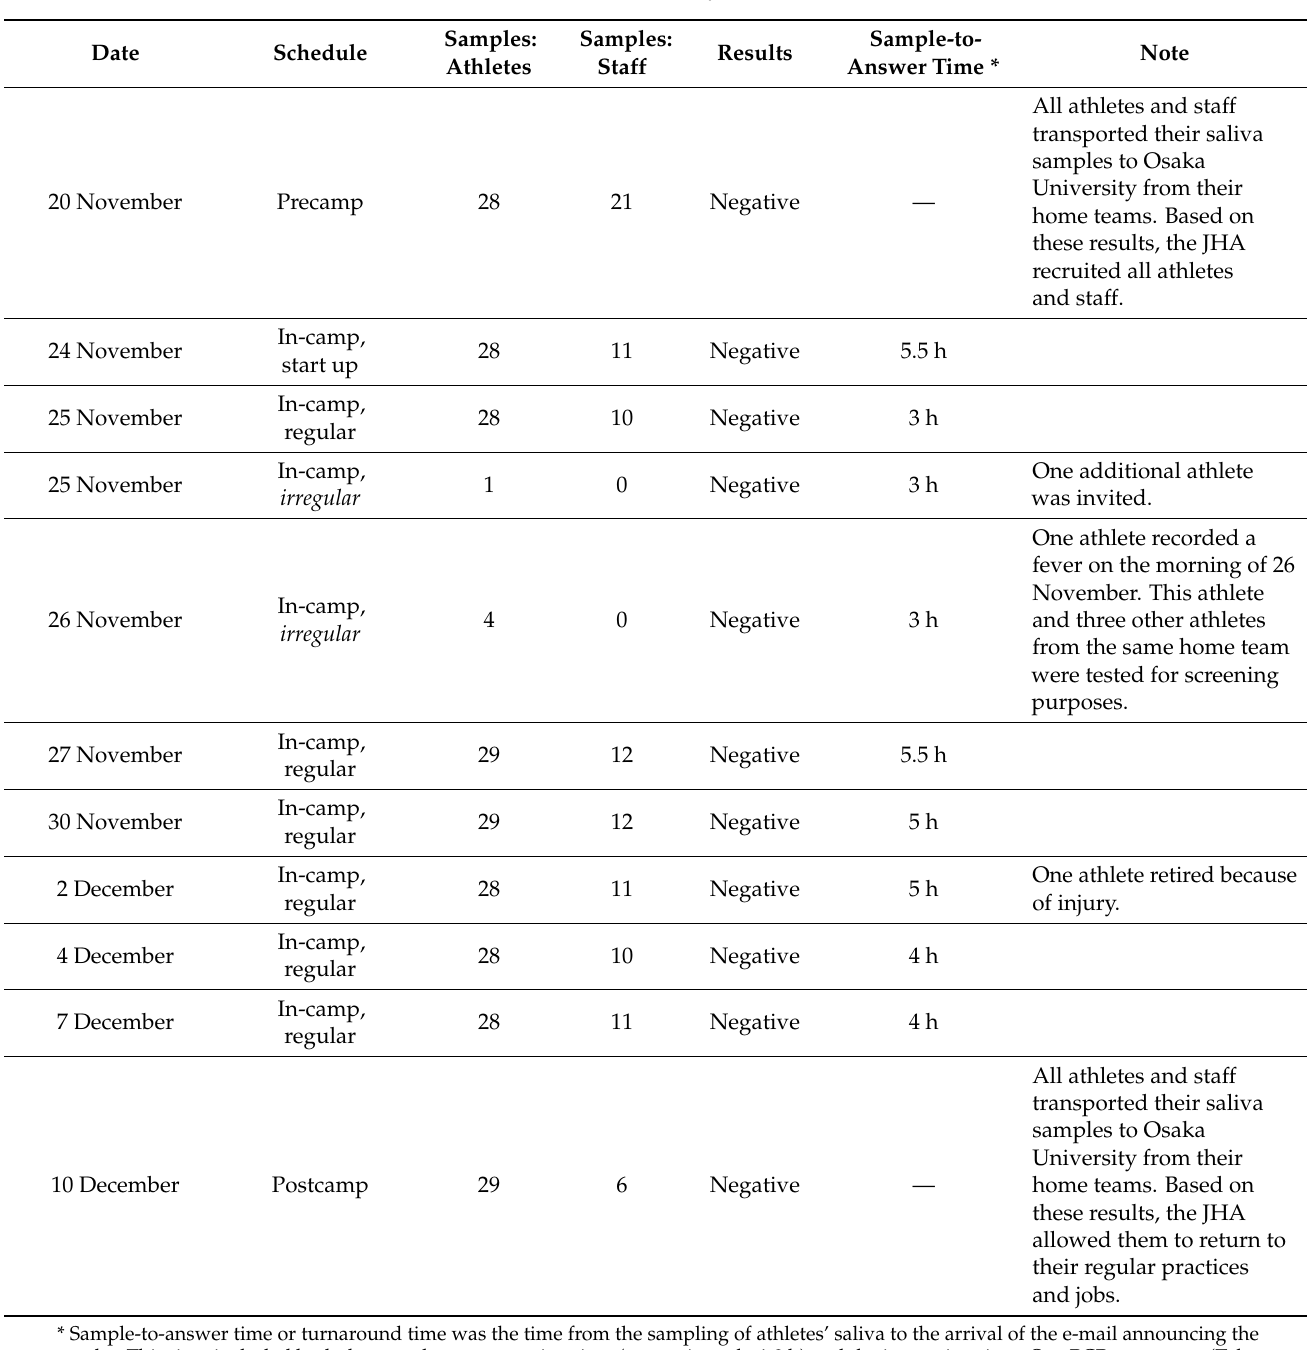
Table 2. PCR test history and